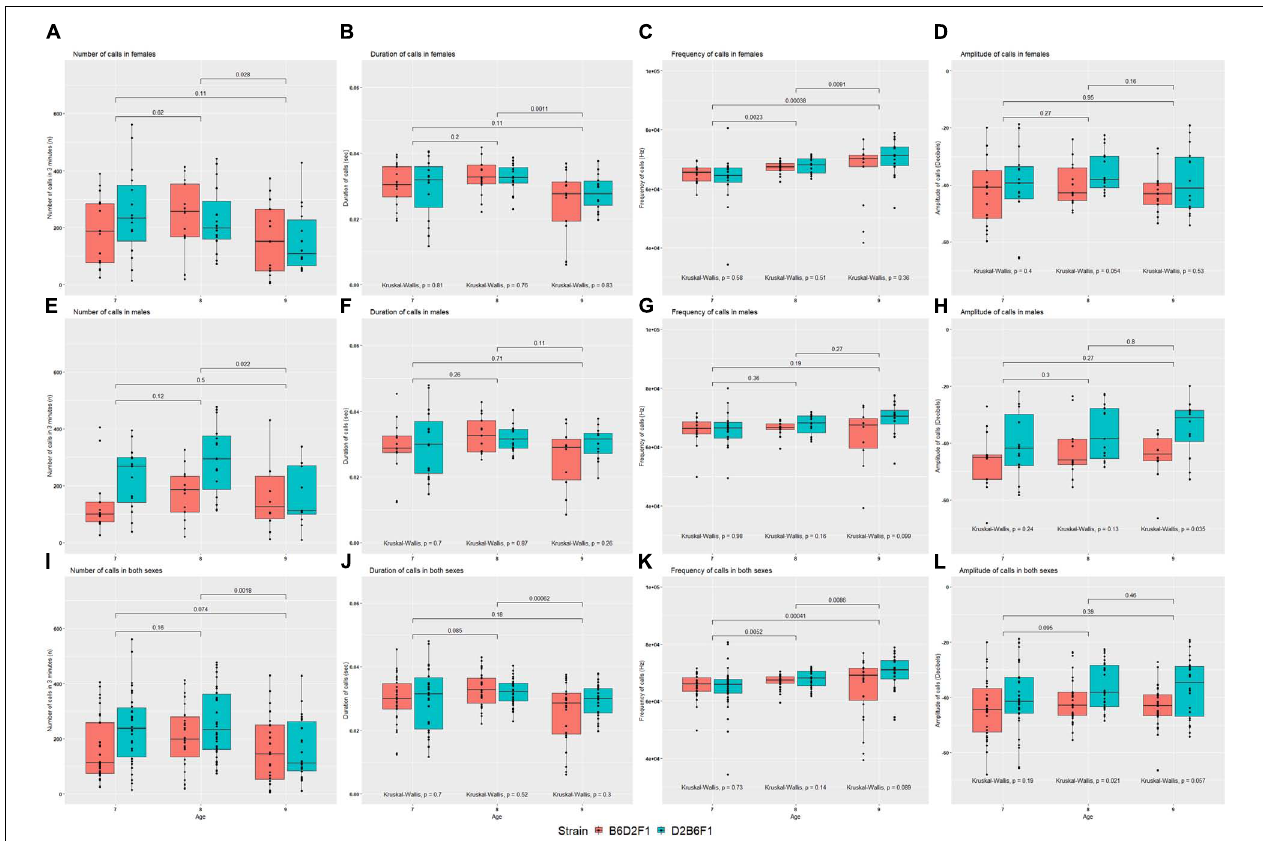
FIGURE 4 | Mean values for the four quantitative traits in females (A–D) , males (E–H) and combined both sexes (I–L) of the reciprocal F1 cross (B6D2F1 and D2B6F1). Between day comparisons were calculated using the Wilcox test and are shown at the top of each plot, whereas comparisons between strains were calculated by the Kruskal–Wallis test and are shown at the bottom of each plot. TABLE 3 | Estimated significance of strain, age, sex and their interactions on 12 quantitative morphological traits in the B6/D2 diallel cross, estimated by ANOVA. Morphological